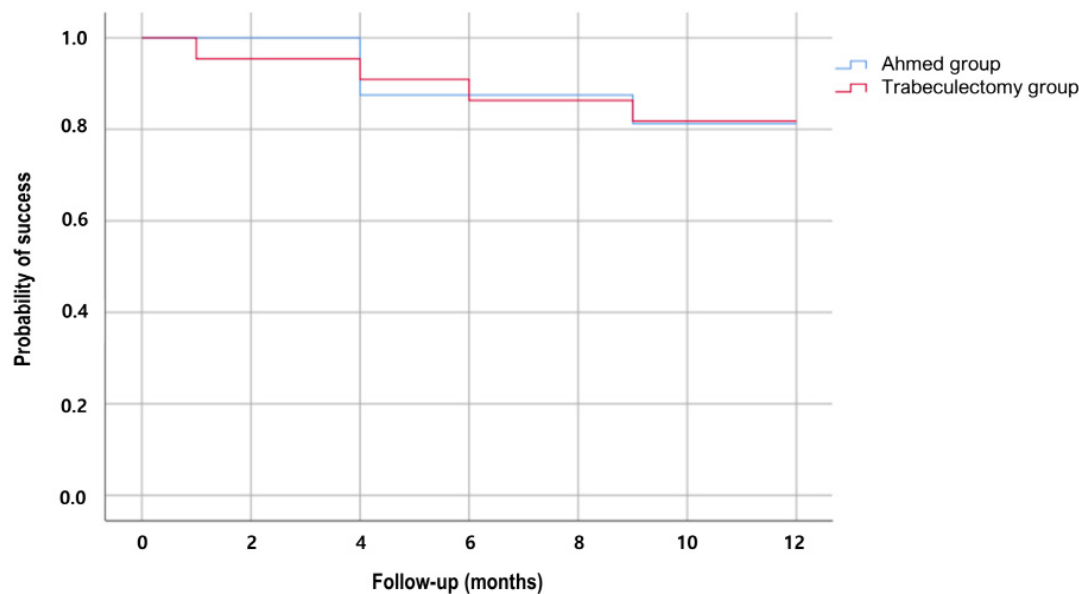
Figure 1. Kaplan–Meier plot showing the cumulative probability of success after 1 year in the Ahmed group versus trabeculectomy group. The success rates at 1-year follow-up were 81.3% in the Ahmed group and 81.8% in the trabeculectomy group (Log-rank test, p = 0.987). At the one-year postoperative follow-up, three eyes (18.8%) in the Ahmed group and four eyes (18.2%) in the trabeculectomy group showed surgical failure (Table 2). The mean